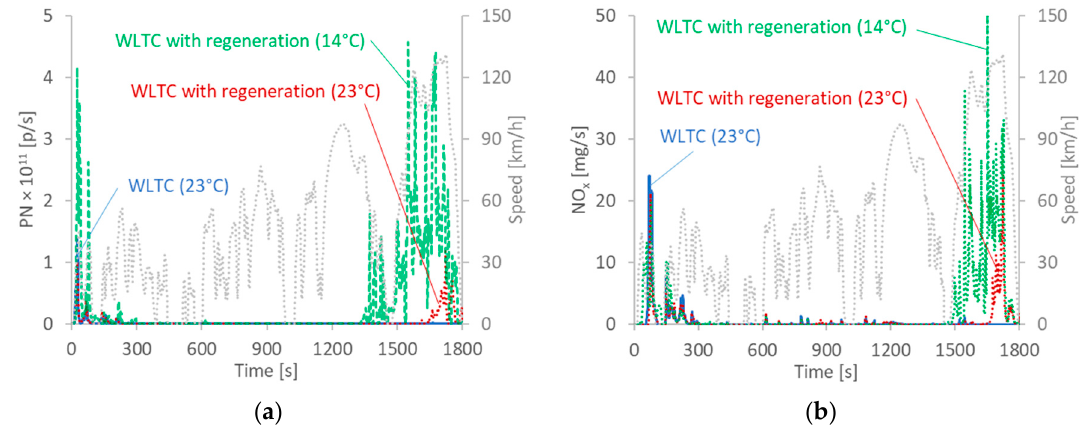
Figure 3. Real time concentrations over the Worldwide Light-duty Test Cycle (WLTC) at 23 ◦ C and 14 ◦ C (with regeneration) as measured from the dilution tunnel: ( a ) Particle Number (PN) > 23 nm; ( b ) NO x